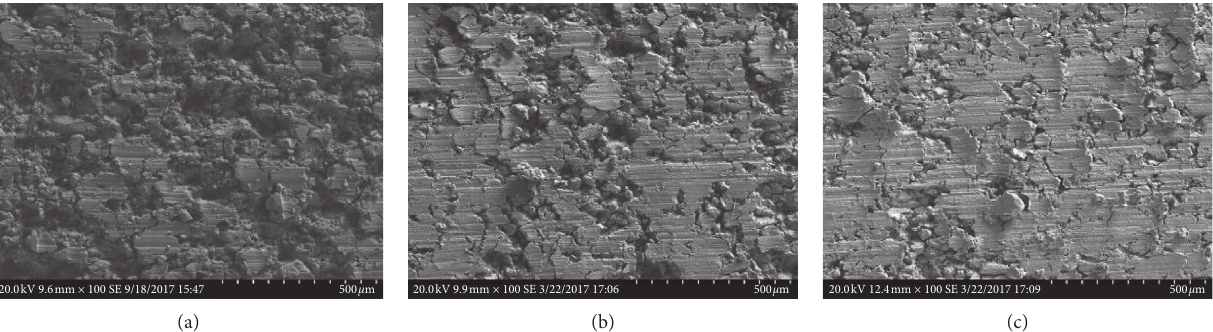
Figure 7: Machined surface morphologies produced with cutting thicknesses of (a) 0.05 mm, (b) 0.14mm, and (c) 0.26mm.